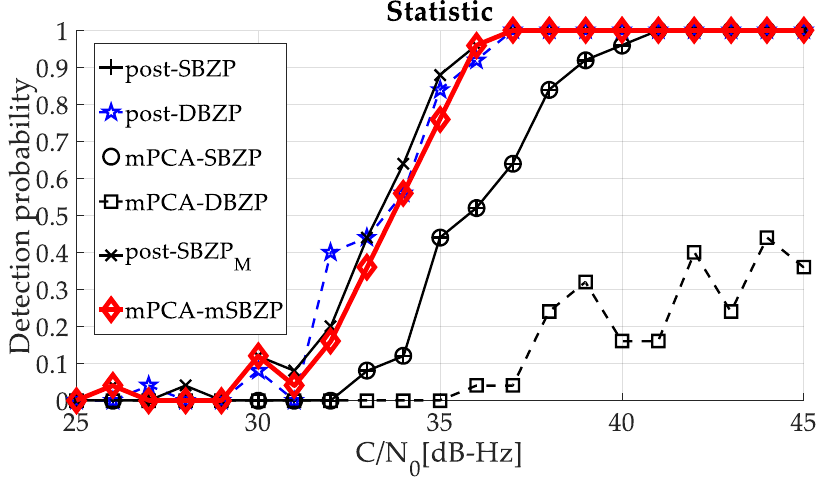
Figure 23 . Detection probability performance of mPCA mSBZP algorithm for SC acquisition .